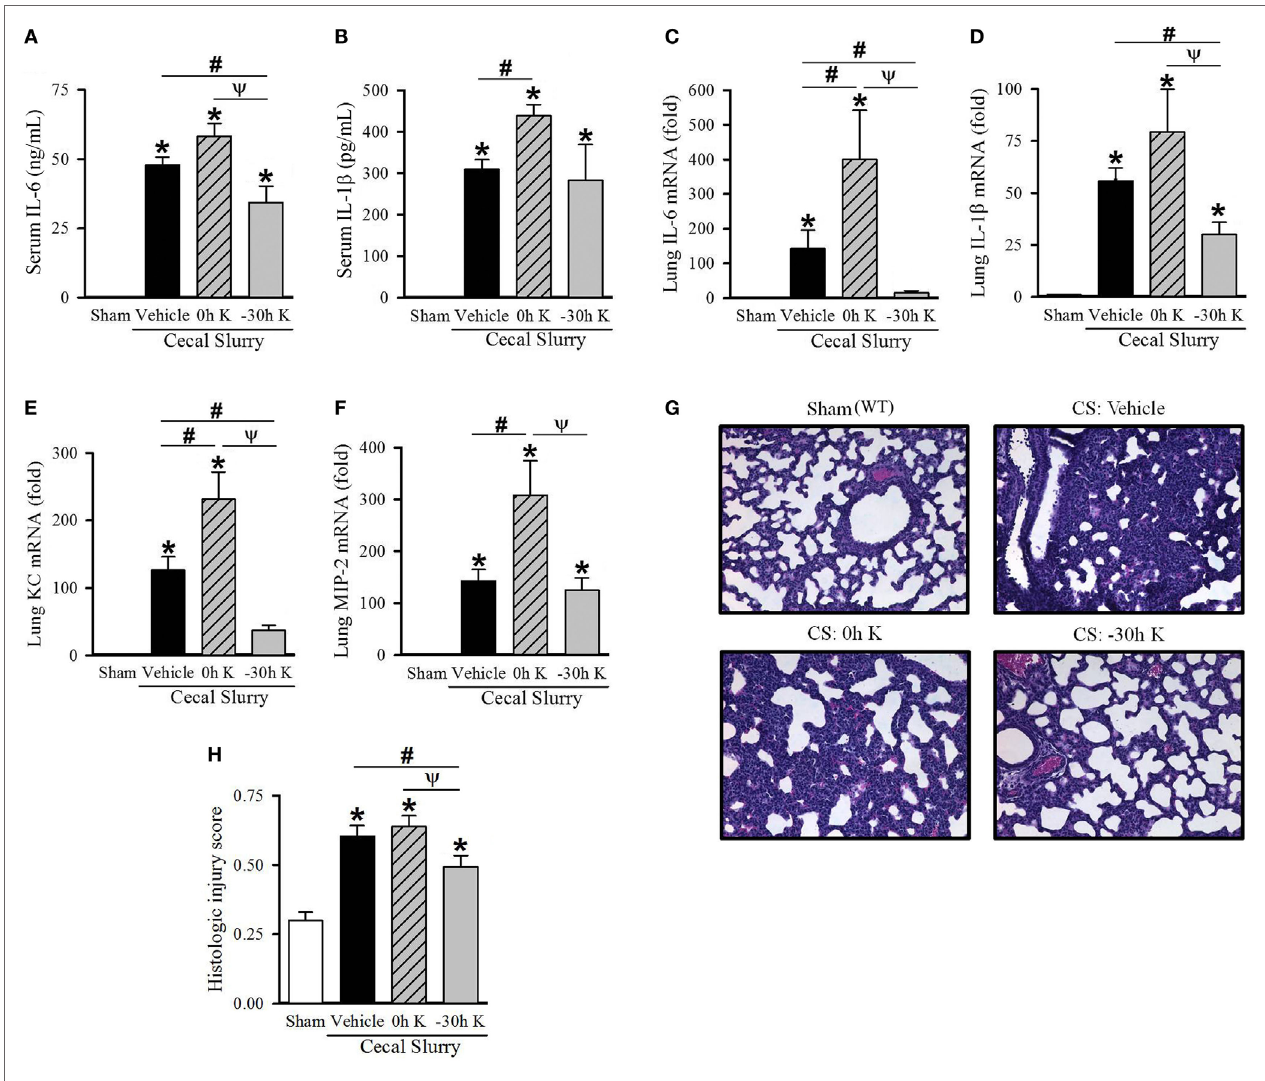
FigUre 1 | Effect of KRN treatment timing on inflammation and pulmonary injury in septic neonatal mice. Neonatal C57BL/6 pups received KRN (0.2 µg/g BW) or vehicle (2.5% dimethyl sulfoxide in PBS) intraperitoneal (i.p.) within 1 h after (0 h K) or 30 h prior to ( − 30 h K) sepsis induction. Sepsis was induced by i.p. injection of cecal slurry (0.9 mg/g BW); serum and lungs were harvested 10 h later. Serum levels of (a) IL-6 and (B) IL-1 β were measured by enzyme-linked immunosorbent assay. The mRNA levels of (c) IL-6, (D) IL-1 β , (e) KC, and (F) MIP-2 in the lungs were determined by qPCR. (g) Shown are representative hematoxylin and eosin-stained sections of the lung from sham, vehicle-treated, 0 h KRN-treated and − 30 h KRN-treated animals at 200 × magnification. (h) Histologic lung injury score was calculated for each group, with a maximum possible score of 1. Data expressed as mean ± SEM ( n = 6–8 per group) and compared by one-way analysis of variance (* p < 0.05 vs. Sham, # p < 0.05 vs. Vehicle, Ψ p < 0.05 vs. 0 h